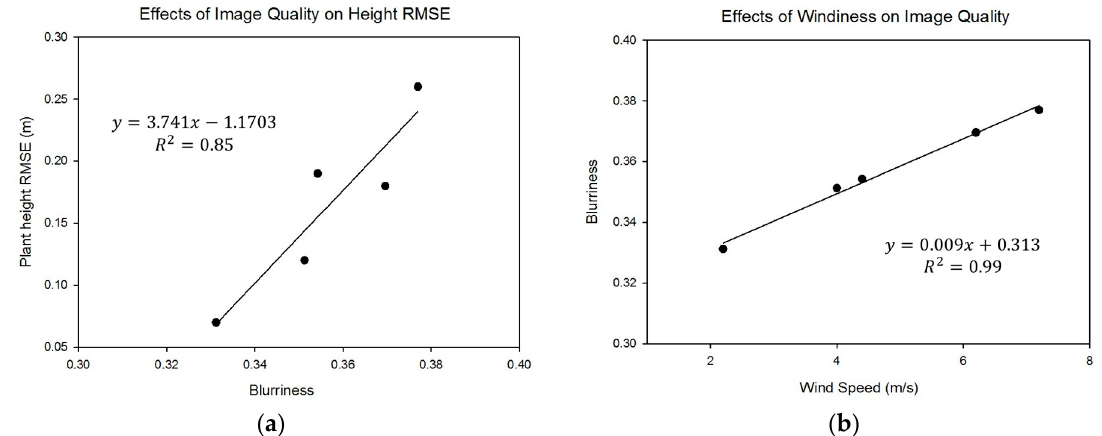
Figure 18. ( a ) Effects of image quality on height RMSE and ( b ) effects of windiness on image quality.